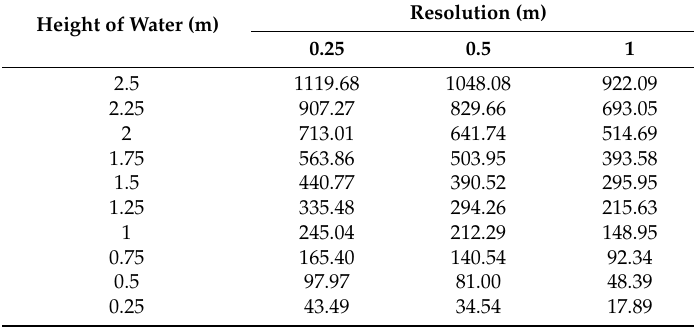
Table A2. Creek A Volume (m 3 ) from Terrestrial Lidar, rounded to two decimal places.